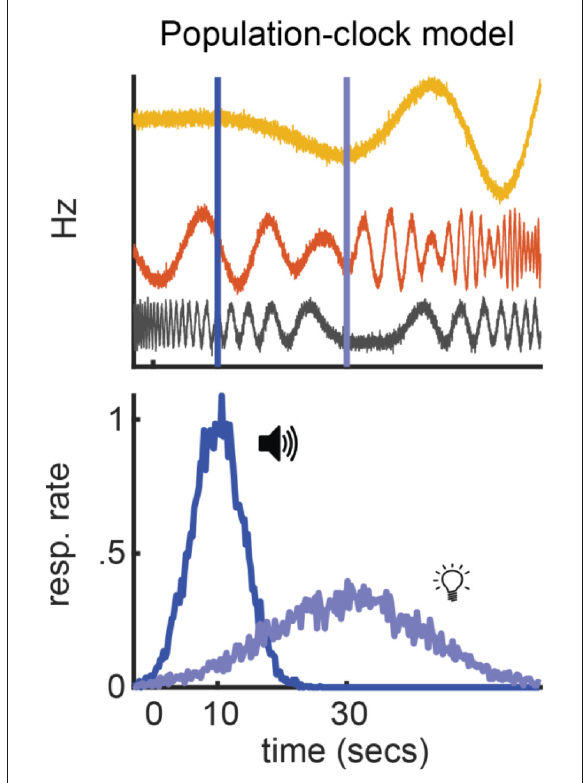
FIGURE4 Population-clock model. Simple population-clock model during a peak-procedure where a tone and light signal reward after 10 and 30 s, respectively. Top: Nonlinear population activity from three neurons. Bottom: Behavior coincides with each cue’s